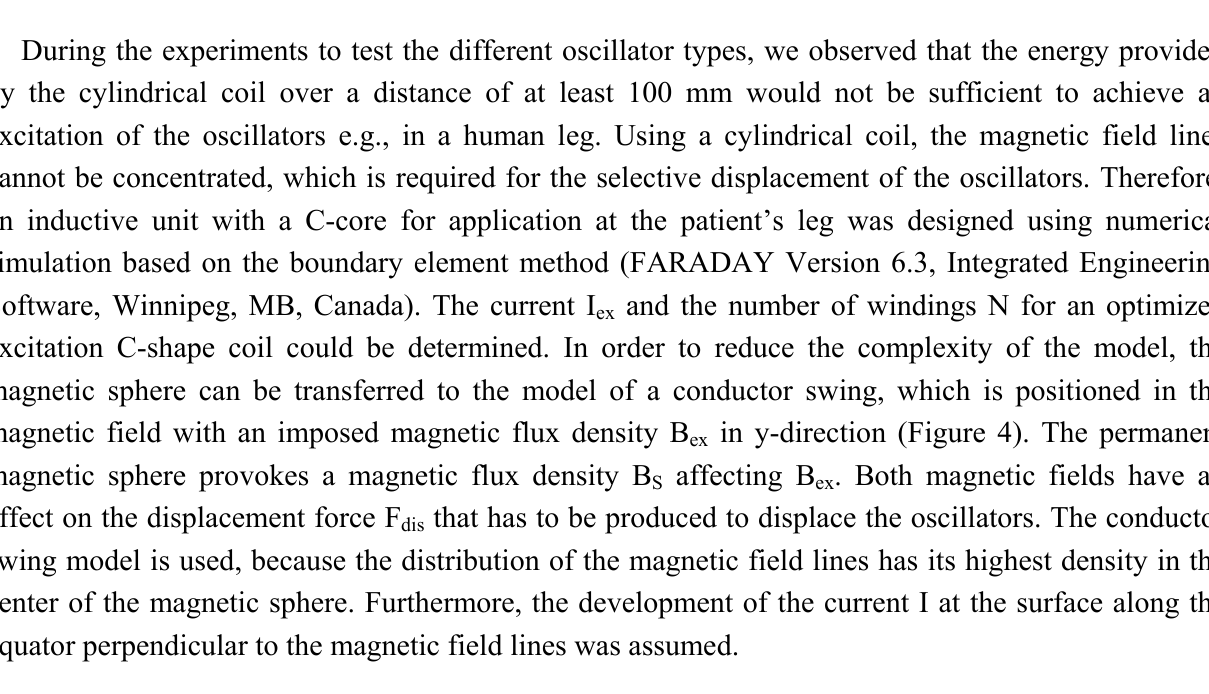
Figure 4. Transfer of the magnetic sphere to a simplified conductor swing model for calculation of the magnetic flux density B ex